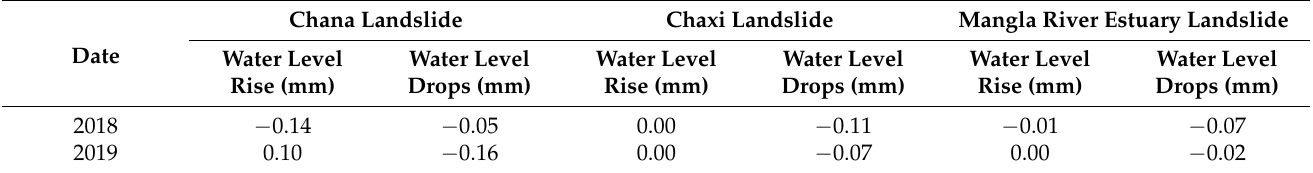
Negative values indicate downward land displacement, and positive value indicate upward landslide